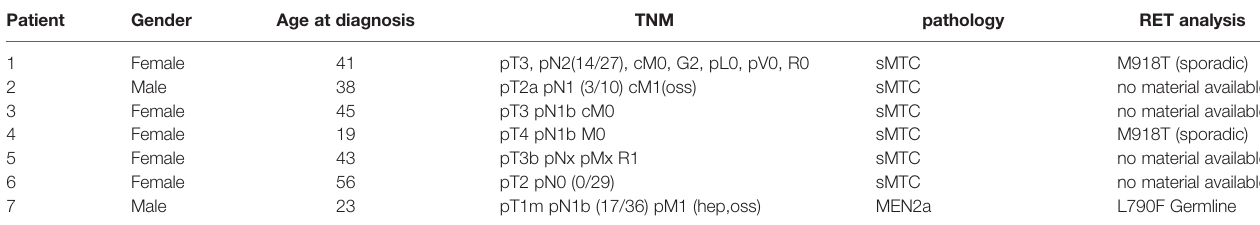
TABLE 2 | Patient